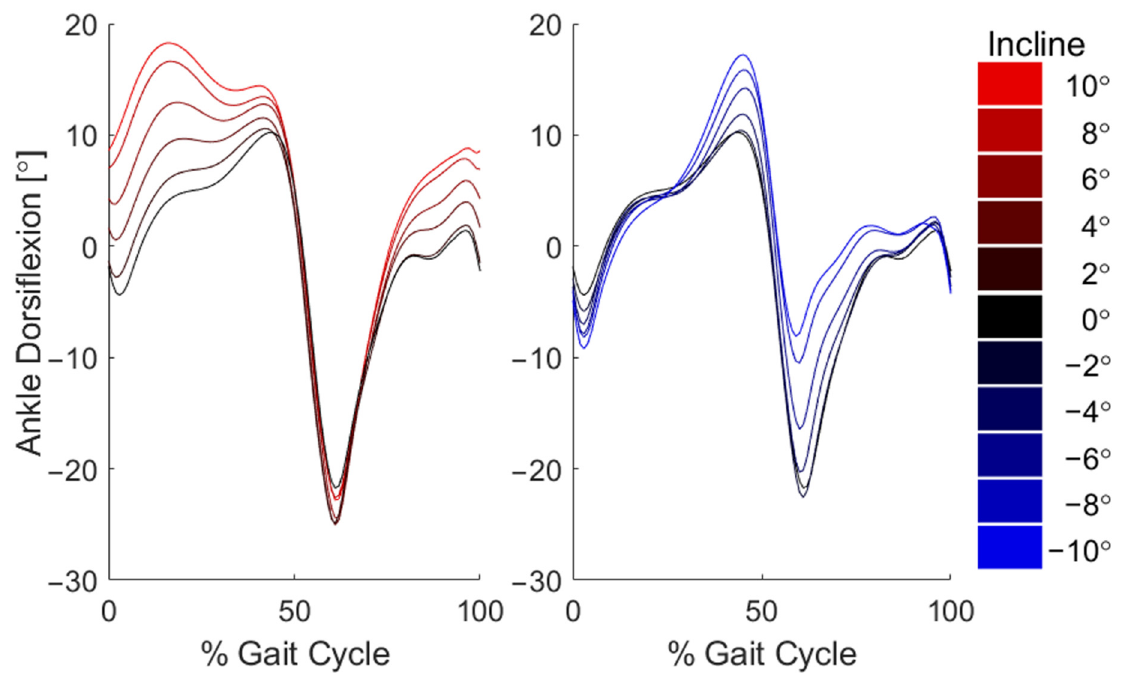
Figure A4. Mean ankle flexion angles from each slope bin.